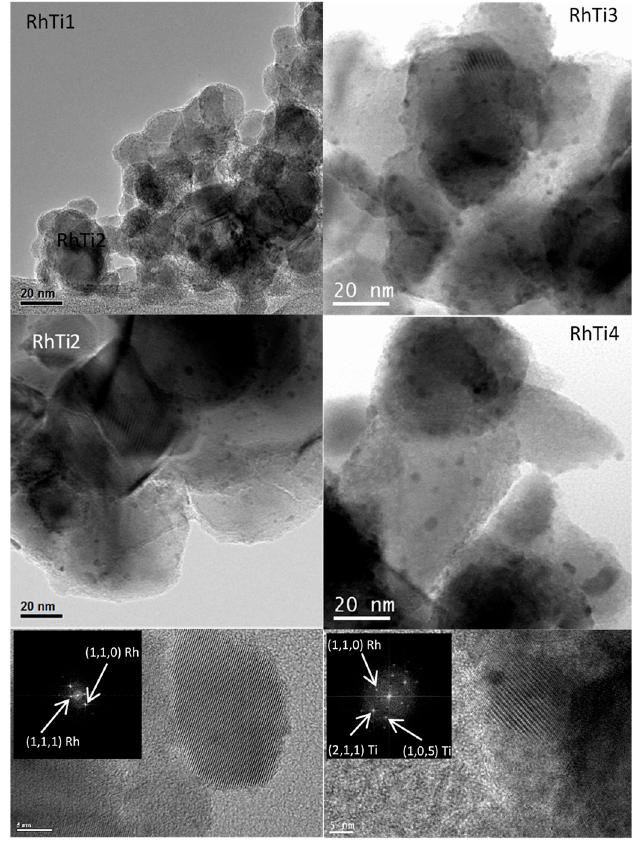
Figure 4. TEM images of RhTi1, RhTi2, RhTi3 and RhTi4 catalysts. Table 1. Net percentage, surface area, dispersion and metal particle size for each catalyst.